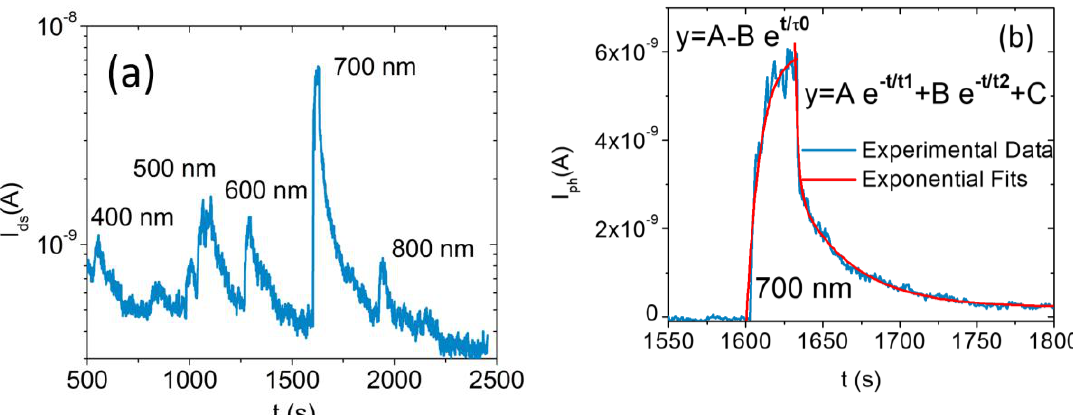
Figure 7. ( a ) Drain-source current measured under 30 s laser pulses at different wavelengths ( V ds = + 5 V , V gs = 0 V , P ∼ 10 − 4 mbar ). ( b ) Photocurrent generated by a 30 s laser pulse at the wavelength of ∼ 700 nm and optical power ∼ 0.37 mW / cm 2 with exponential fits.